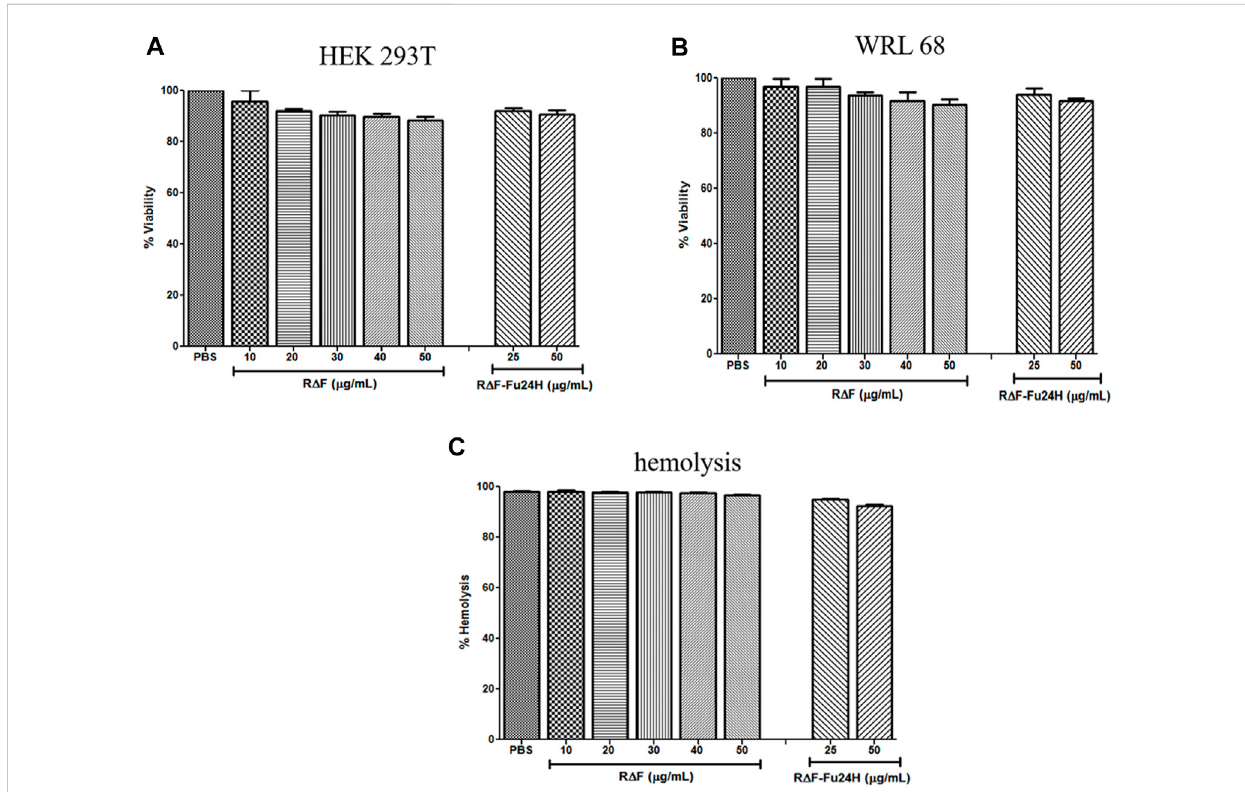
FIGURE 4 Cytotoxicity of different cell lines after treatment with R Δ F NPs and R Δ F-Fu24H complex using MTT assay. Percentage viability for cells treated with R Δ F NPs and R Δ F-Fu24H complex at different concentrations (A) HEK 293T and (B) WRL 68, and (C) Percentage hemolysis caused by R Δ F NPs and R Δ F- Fu24H complex. Data has been reported as mean ± standard deviation (SD) from three separate experiments ( n = 3).